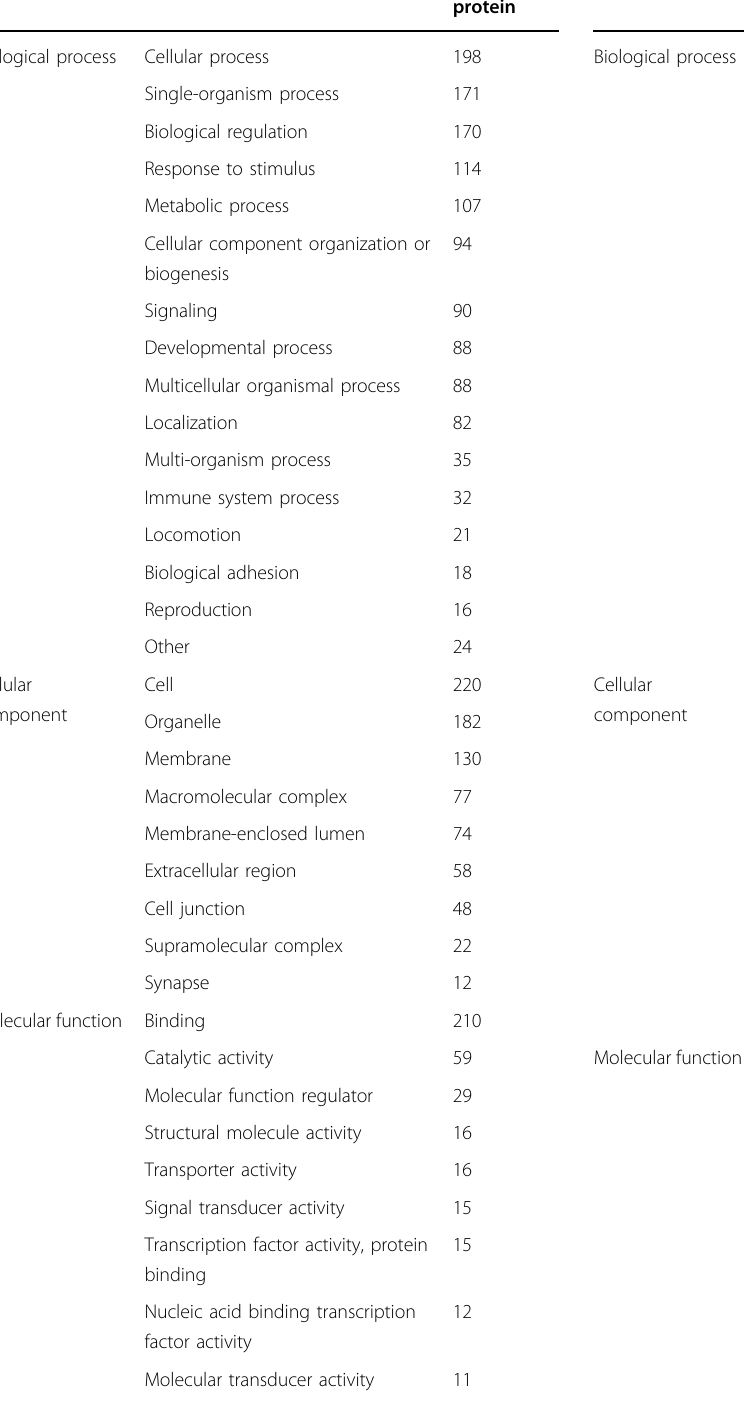
Table 2 GO secondary annotations of proteins with downregulated p-site (WT vs.